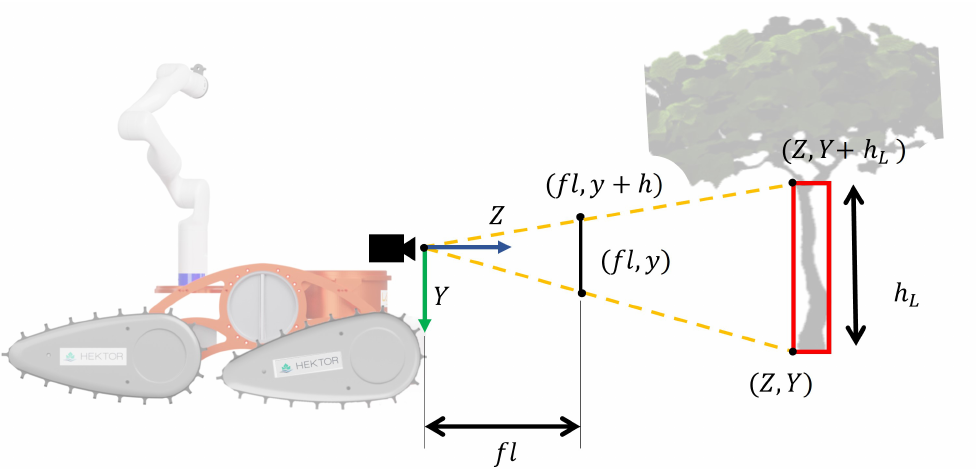
Figure 10. True and apparent object size and position in camera frame and image